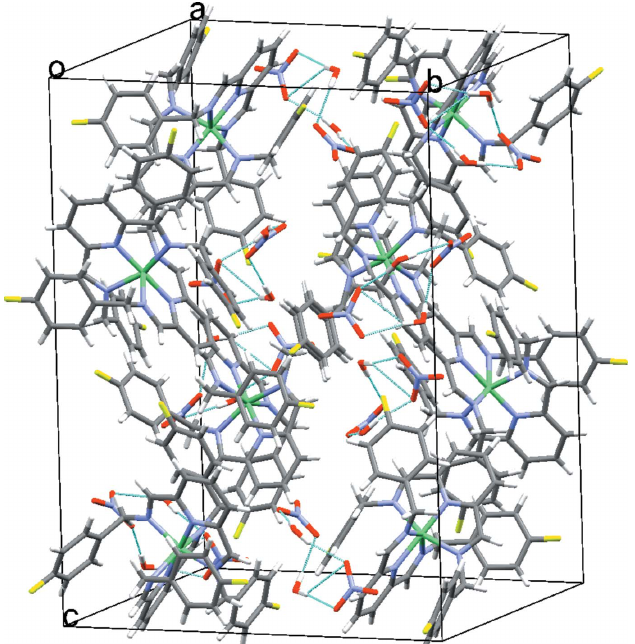
Figure 2 Crystal packing of the title compound showing hydrogen-bonded anionic units (light-blue lines) together with the packing of the molecules in the unit cell, as viewed approximately along the a axis. For clarity, C—H (cid:2)(cid:2)(cid:2) O and C—H (cid:2)(cid:2)(cid:2) F hydrogen bonds are not shown.